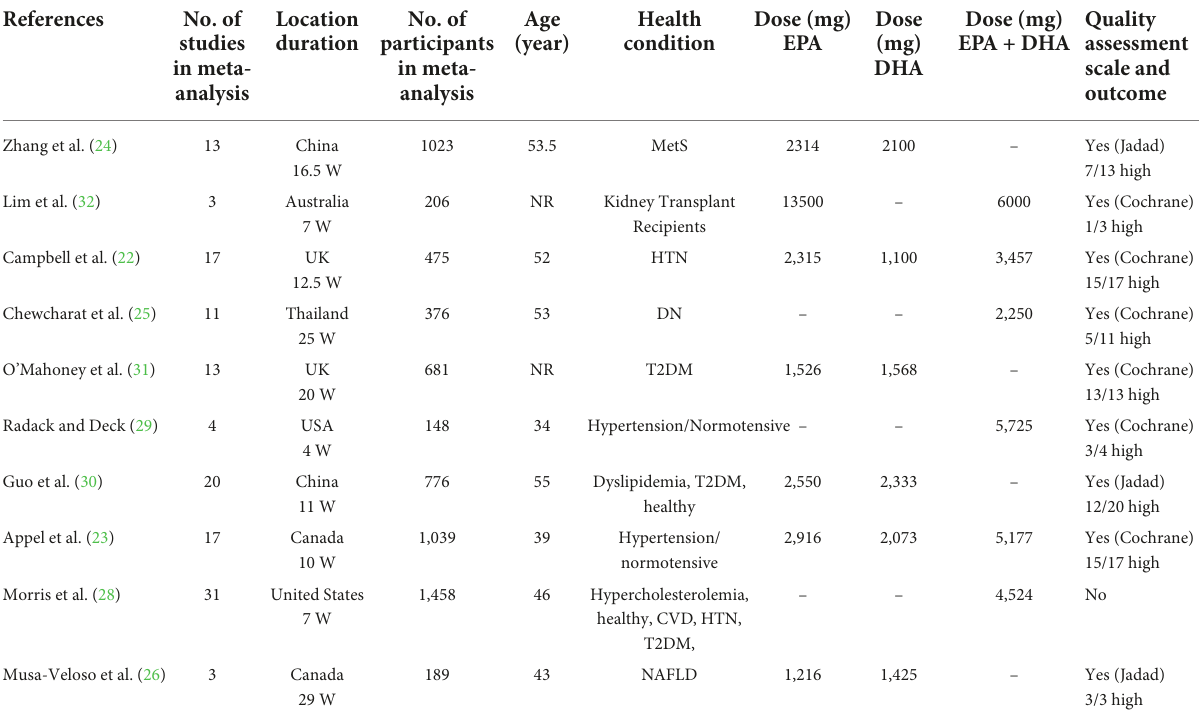
TABLE 1 Study characteristics of included studies.